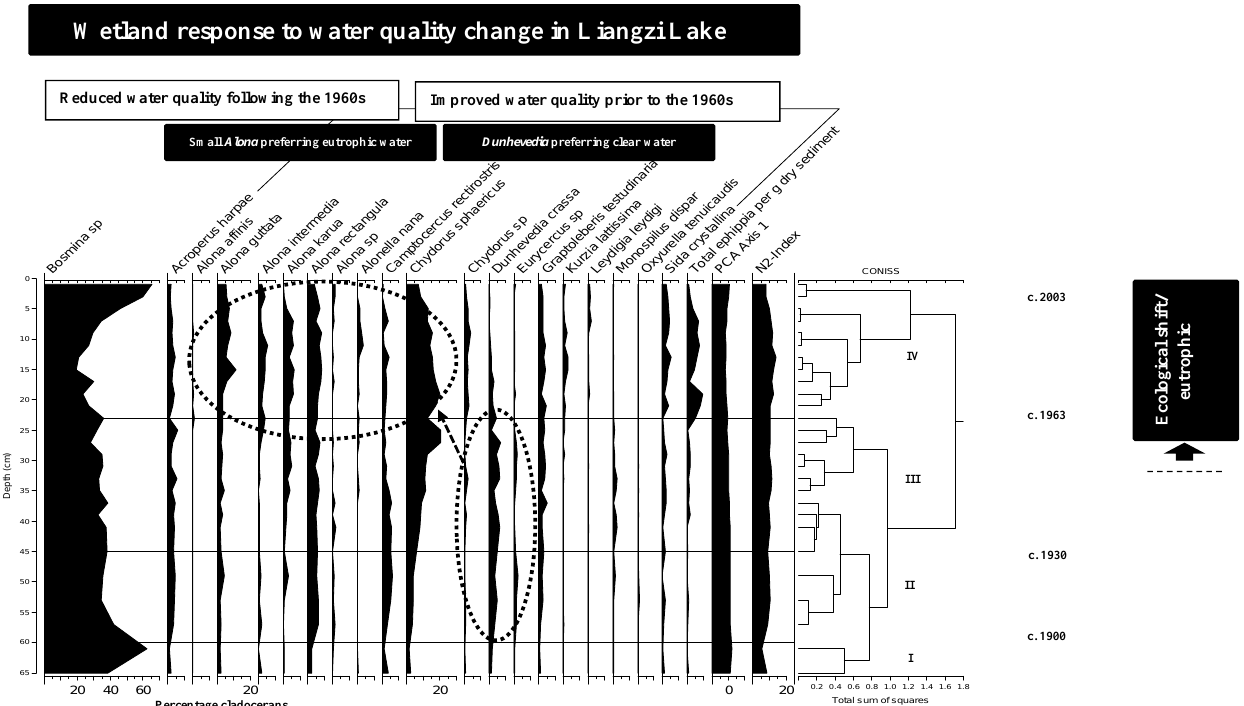
Figure 5. Composition (%) and N2 diversity index of subfossil cladocerans in Liangzi Lake, and their response to past water quality change.